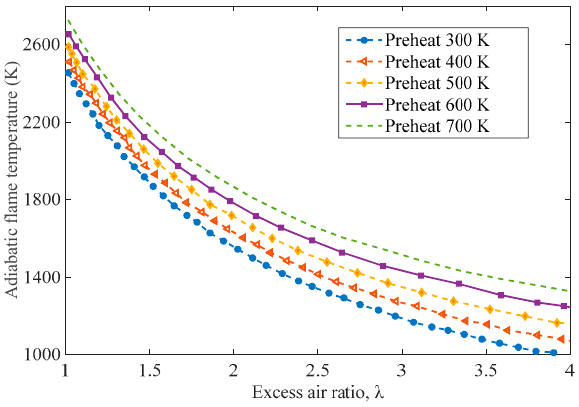
Figure 4. Adiabatic flame temperature for different λ values with different preheats.